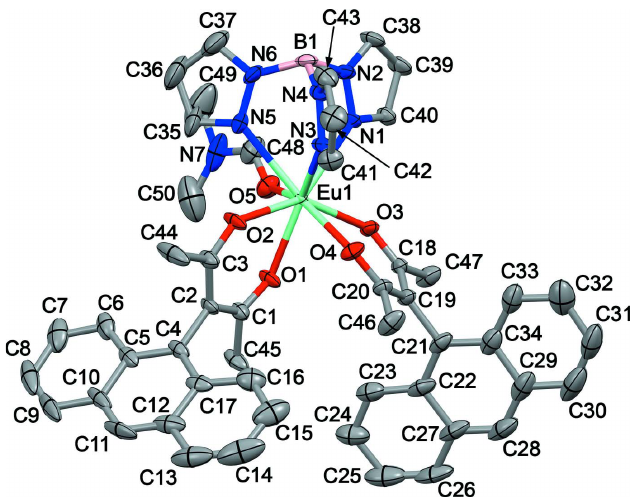
Figure 1 The molecular structure of the title compound. Atomic displacement ellipsoids are drawn at the 50% probability level. H atoms are omitted for clarity of presentation.